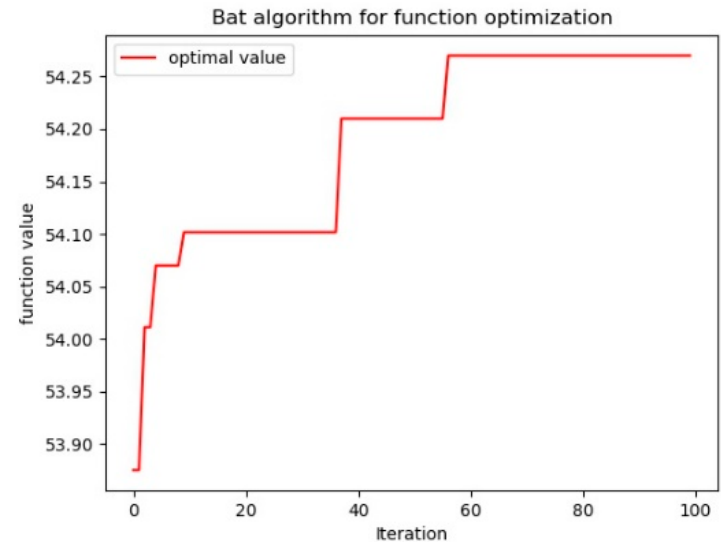
Figure 5. Dynamic optimization curve of fitness function.